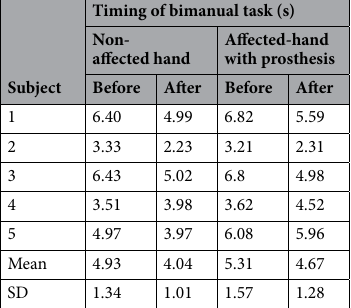
Table 3. Timing of bimanual coordination tasks found from the bimanual reaching task with two small trays.